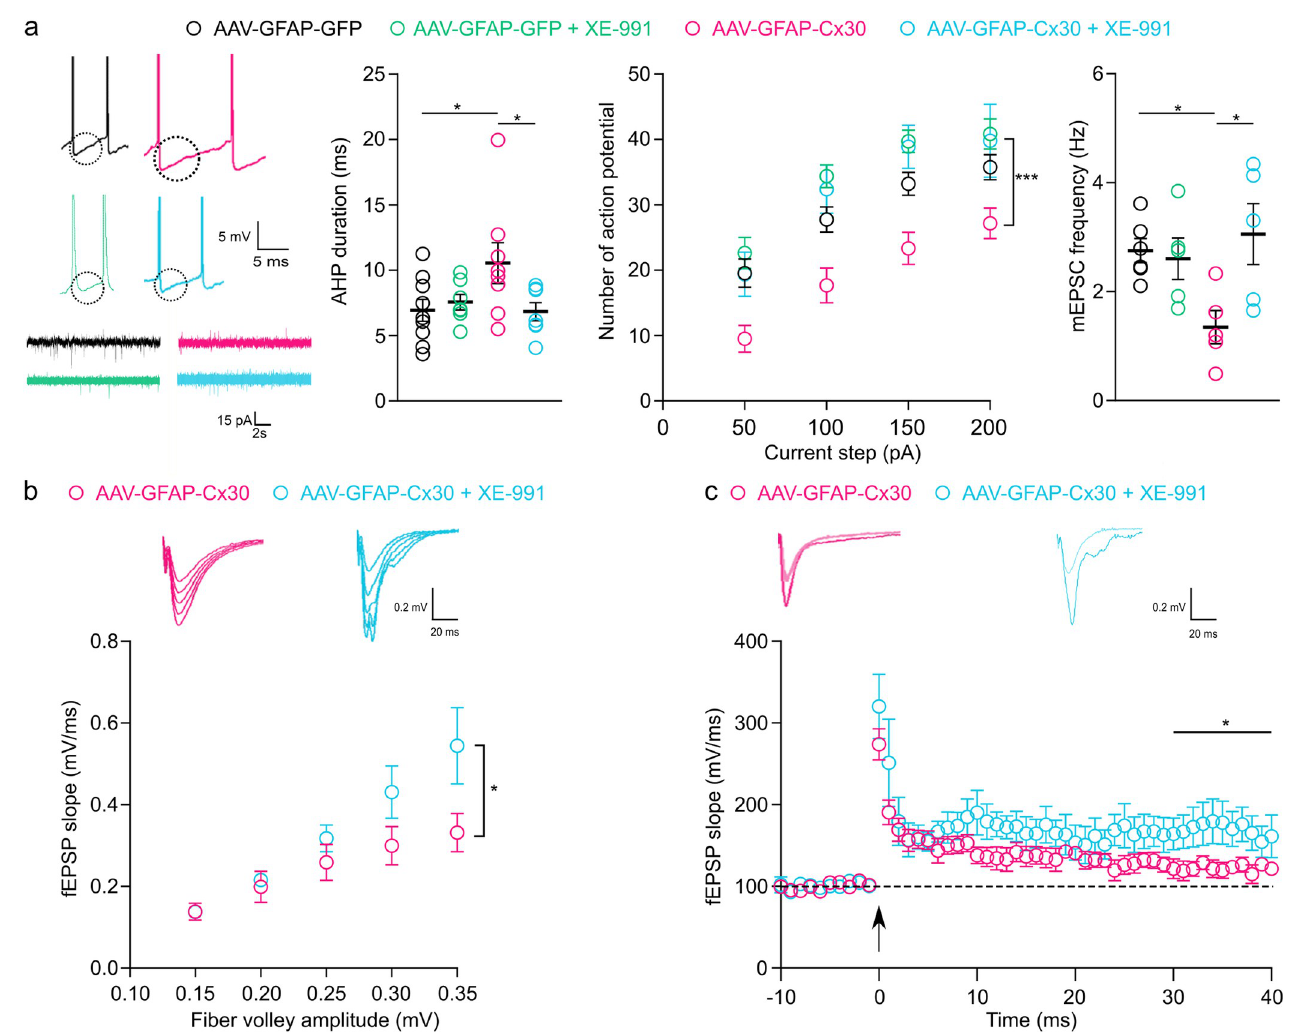
Fig 6. Reducing AHP duration in mice with upregulated astroglial Cx30 restores pyramidal cell excitability and excitatory synaptic transmission. (a) (Left) Sample traces of whole CA1 pyramidal cell recording from mice stereotaxically injected with AAV in the hippocampus in the presence or not of XE-991. The dotted circles delineate the AHP. (Middle Left) AHP durations in CA1 pyramidal cells was unchanged after the application of XE-991 in mice injected with AAV-GFAP-GFP ( n = 8 neurons from 5 mice), AAV-GFAP-GFP with XE-991 (10 μ M, n = 7 neurons from 5 mice), and AHP was restored by the application of XE-911 in AAV-GFAP-Cx30 mice ( n = 8 neurons from 5 mice), AAV-GFAP-Cx30 with XE-991 (10 μ M, n = 7 neurons from 5 mice). * p < 0.05, Mann– Whitney test. (Middle right) Excitability curve with the number of action potentials evoked by current step for mice injected in the hippocampus with AAV-GFAP-GFP ( n = 9 neurons from 5 mice), AAV-GFAP-Cx30 ( n = 8 neurons from 5 mice), or AAV-GFAP-Cx30 + XE-991 ( n = 8 neurons from 5 mice) (AAV: *** p < 0.001, F (2, 93) = 18.6; current step: *** p < 0.001, F (4, 93) = 96.38, two-way ANOVA). (Right) mEPSCs frequencies were not affected by the application of XE-911 in mice injected with AAV-GFAP-GFP ( n = 6 from 5 mice) AAV-GFAP-GFP with XE-991 (10 μ M, n = 5 neurons from 5 mice), but mEPSC frequencies were restored by the application of XE-991 in mice injected with AAV-GFAP-Cx30 ( n = 5 from 5 mice) AAV-GFAP-Cx30 with XE-991 (10 μ M, n = 5 neurons from 5 mice). * p < 0.05, Mann–Whitney test. ( b ) Input–output curves for basal synaptic transmission. fEPSP slope was increased after the application of XE-991 in mice injected in the hippocampus with AAV-GFAP-Cx30 ( n = 10 slices recording from 5 mice) compared to mice injected with AAV-GFAP-Cx30 ( n = 8 slices recording from 5 mice) (XE-991: * p < 0.05, F (1, 75) = 6.623; fiber volley: *** p < 0.001, F (4, 75) = 10.85, two-way ANOVA). ( c ) Tetanus-induced LTP curves (arrow, two 100 Hz tetani for 1 s, interval 20 s) and representative traces. LTP maintenance for the last 10 min (30–40 min) was restored for AAV-GFAP-Cx30 in the presence of XE-991 ( n = 9 slices from 5 mice) compared to AAV-GFAP-Cx30 ( n = 7 slices from 5 mice). Individual numerical values are indicated in S1 Data. * p < 0.05, Welch’s t test. AAV, adeno-associated vector; AHP, afterhyperpolarization; fEPSP, field excitatory postsynaptic potential; LTP, long-term potentiation; mEPSC, miniature excitatory postsynaptic current.